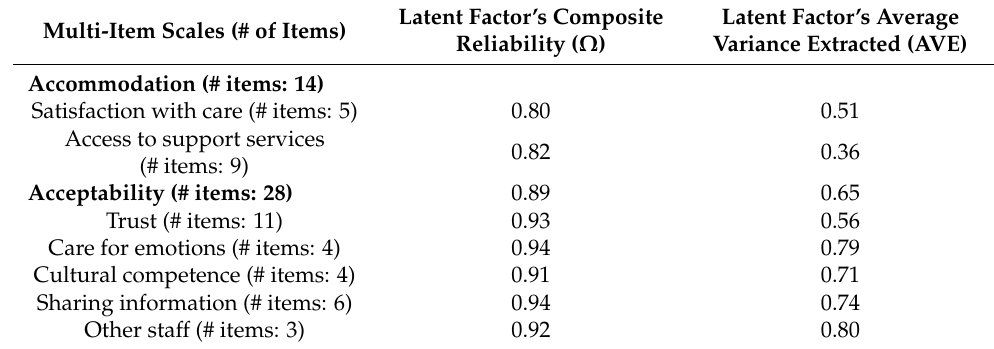
Table 4. Composite Reliability and Average Variance Extracted for Latent